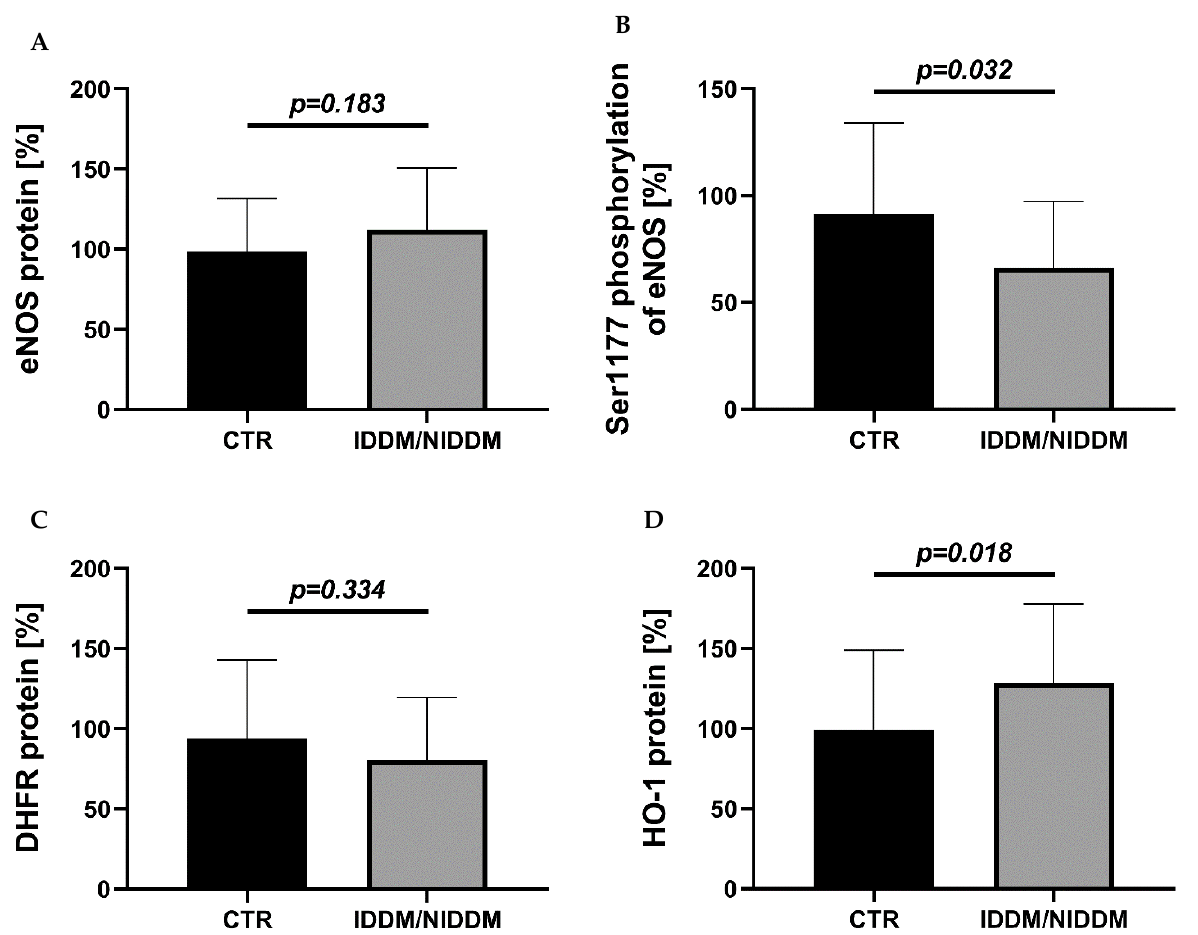
Figure 2. Expression of vasoactive regulatory protein and antioxidant enzyme/response in myocardium. ( A ) Absent upregulation of dysfunctional enzyme (eNOS protein) in the diabetic (IDDM/NIDDM) versus the control (CTR) group. ( B ) Significant decrease in activated eNOS (Ser1177 phosphorylation) in the IDDM/NIDDM versus CTR group. ( C ) Slightly lower DHFR expression in the IDDM/NIDDM versus CTR group. ( D ) Significant upregulation of the antioxidant stress-response enzyme HO-1 in the IDDM/NIDDM versus CTR group. Data are mean ± SD of n = 37–39 (CTR) and 17 (IDDM/NIDDM) ( A , B ) and n = 38 (CTR) and 16 (IDDM/NIDDM) ( C ) and n = 37 (CTR) and 16 (IDDM/NIDDM) ( D ) patients. Unpaired t -test in ( A – C ) and Mann–Whitney test in ( D ). CTR, control; IDDM, insulin-dependent diabetes mellitus type 2; NIDDM, non-insulin dependent diabetes mellitus type 2.